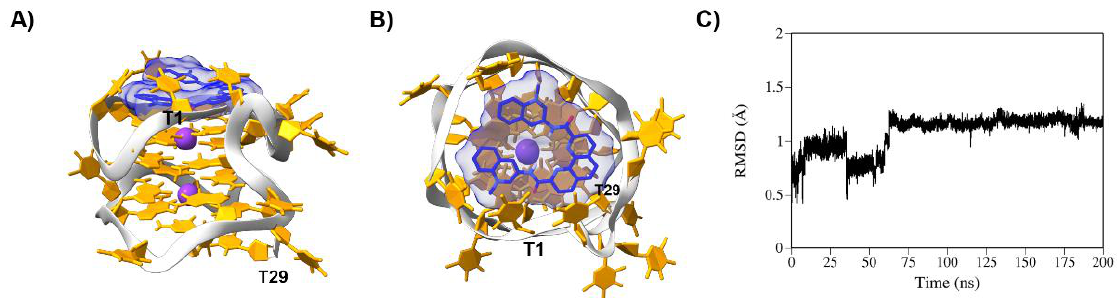
Figure 7. Final snapshots of 200 ns MD simulations of the complex between AT11-L2 G4 and PhenDC3. ( A ) Side view and ( B ) top view. The backbone is highlighted in light grey, while nucleotides are depicted in orange. K + is shown in purple. The ligand is depicted in blue. The first and last nucleotides of AT11-L2 are also shown. ( C ) RMSD plot of the 200 ns simulation of AT11-L2 G4/PhenDC3 complex.